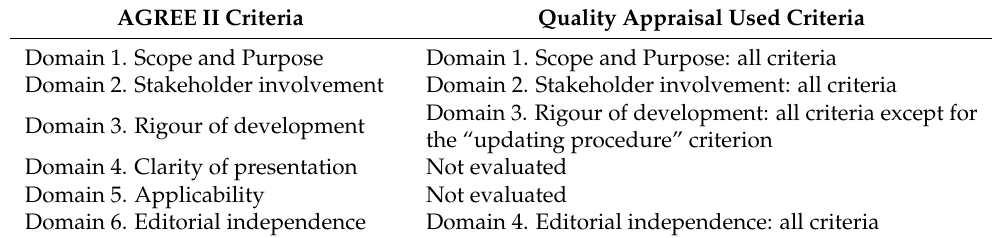
Table 1. The AGREE-II criteria used for quality